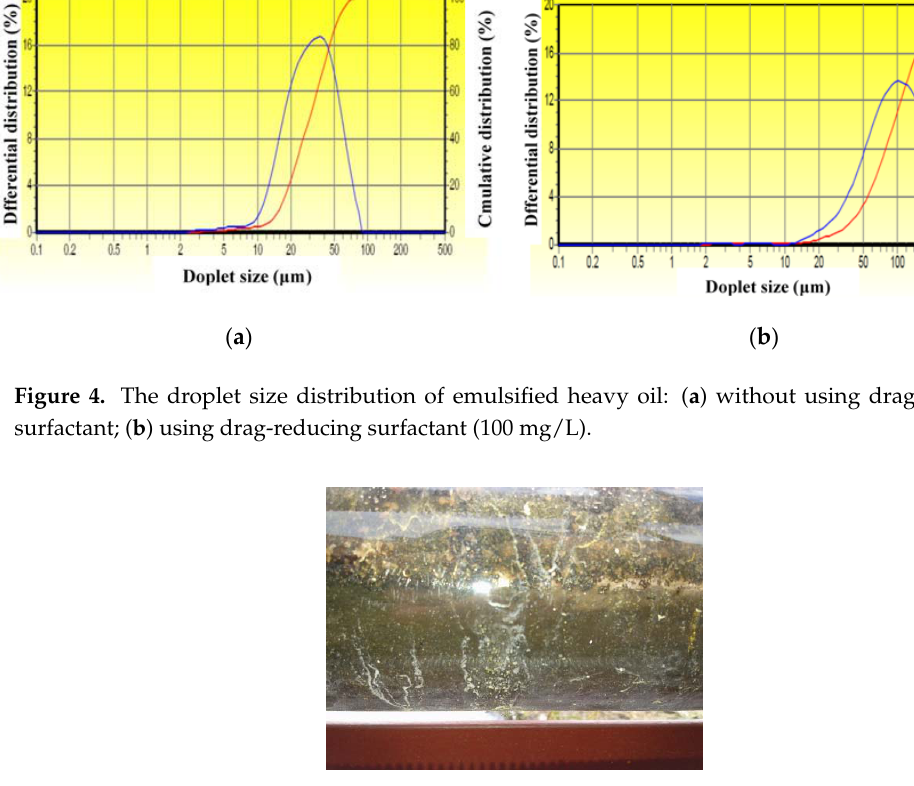
Figure 5. Flow regime observation of heavy crude emulsions (the flow of emulsions with volumetric water content of 75% was created by 100 mg/L drag ‐ reducing surfactant in a 1.2 m ‐ long, 73 mm ‐ diameter visual glass tube).